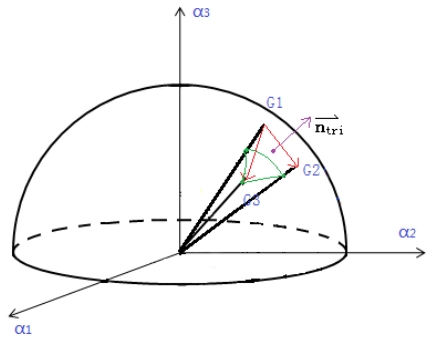
Figure 7. A triangle after triangulation.